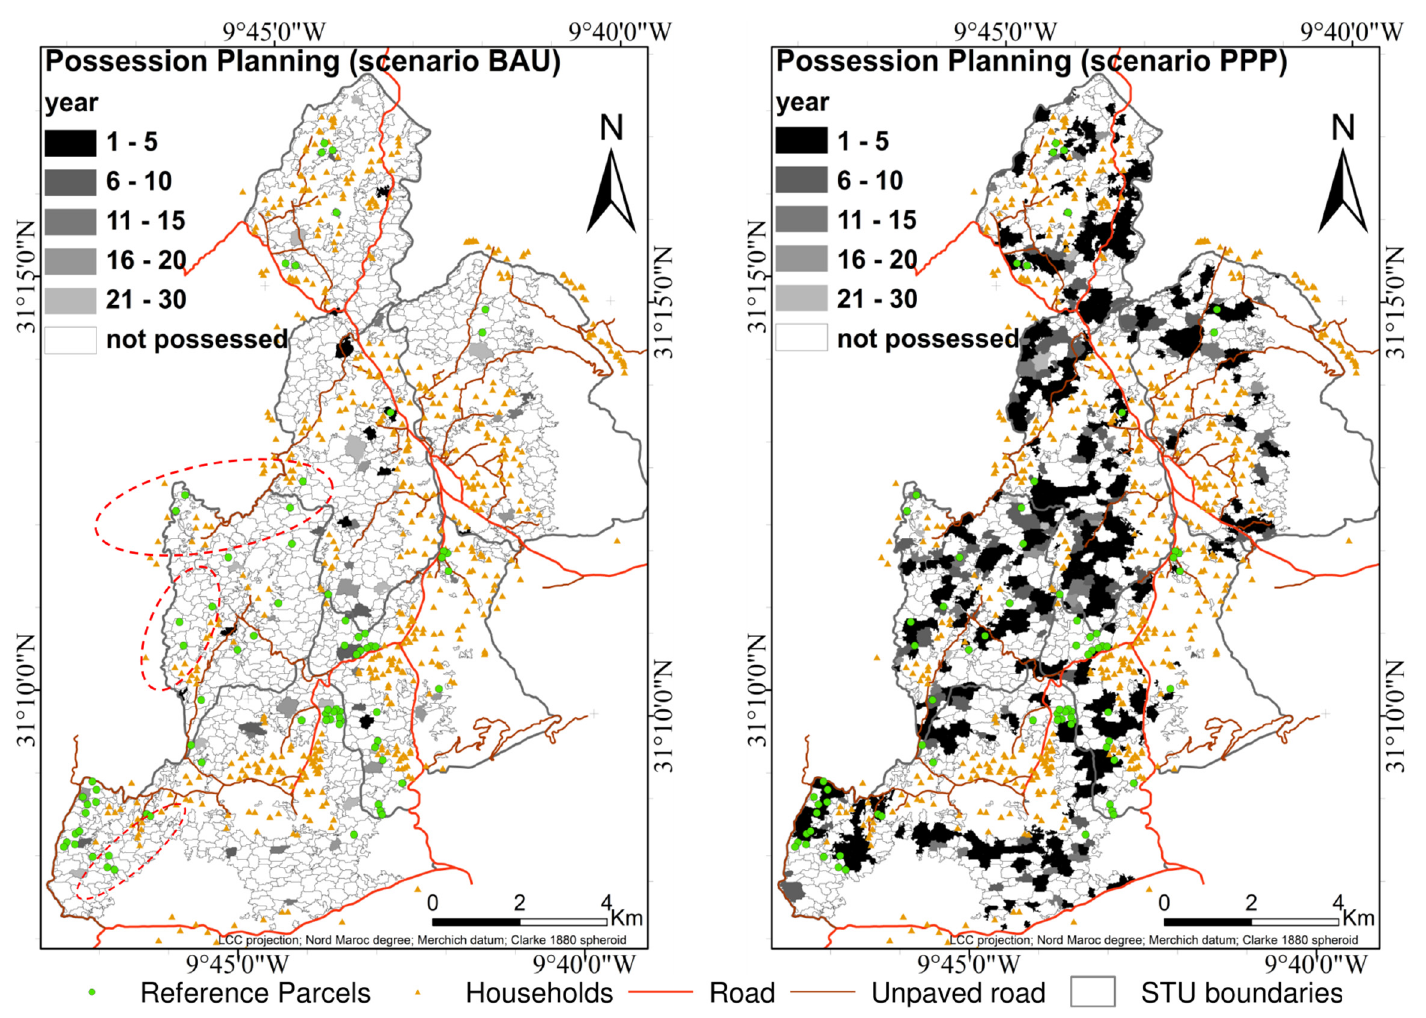
Figure 5. Simulated possession planning (schedule) dynamics for BAU ( left ) & PPP ( right ) scenarios . Dotted line circles delimits areas where the possession dynamics are under-estimated. The grey scale indicates the time steps for a parcel to change status tenure over the 30- year simulation